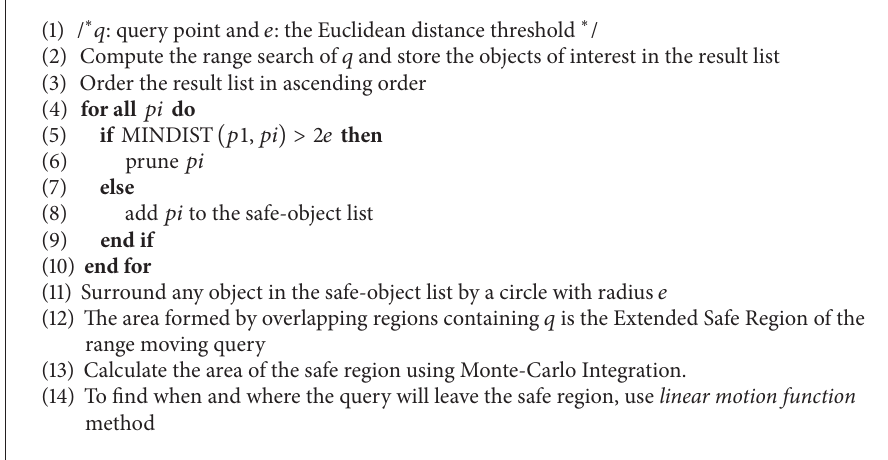
Algorithm 1: Extended Safe Region algorithm.